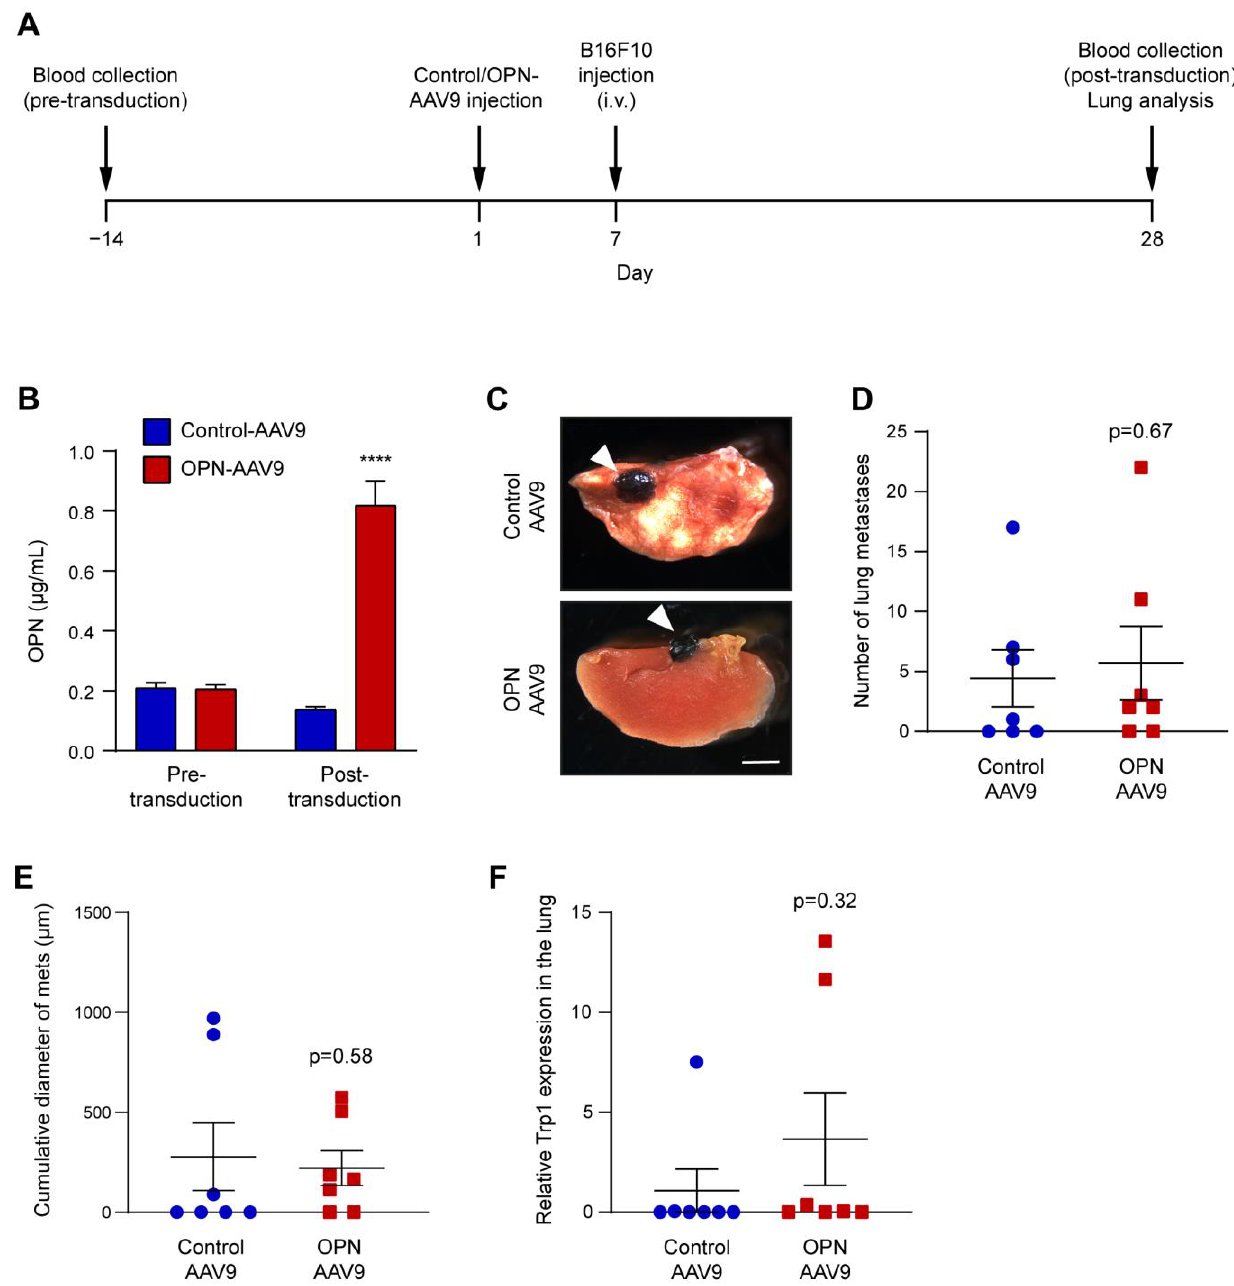
Figure 6. Increased cOPN does not promote lung metastasis in a melanoma model of experimental metastasis. ( A ) Schematic illustration of the experimental time course. Mice were first injected i.v. with control-AAV9 and OPN-AAV9 at 5 × 10 10 viral particles per animal, and 6 days later transplanted with 1 × 10 5 B16F10 melanoma cells i.v. Blood and lungs were collected for analysis 28 days after the injection of the AAVs. Additionally, blood was collected 14 days before viral transduction to determine pre-transduction baseline levels of OPN. ( B ) Plasma OPN levels were determined by ELISA. Control and OPN-AAV9 transduced animals were compared using Student’s t -test; n = 7 for Control-AAV9 and n = 6 for OPN-AAV9. ( C ) Representative images of B16F10 metastatic nodules in the lungs (indicated by white arrowheads). Scale bar: 2 mm. ( D ) Number of metastatic nodules in the lungs. ( E ) Quantification of the metastasis size (cumulative diameter of all measured metastases). ( F ) Expression of the melanoma marker Trp1 in the lungs. Control and OPN groups in ( D – F ) were compared using the Mann Whitney test; n = 7 per group. **** p <